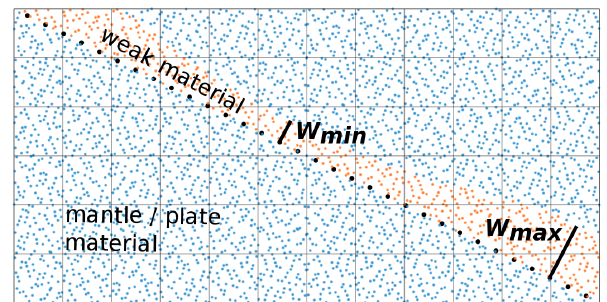
Figure 3. Schematic of the embedded fault (EF) implementation. The EF is a modification to the standard weak layer approach (WL). As with the WL, shear localizes due to a finite-width layer of weak material (represented by orange particles). A reference line of tracer particles (black points) is advected with the flow, at the base of the weak material layer. This line provides a reference to enforce width limits on the weak material, denoted by W min and W max . At each time step we remap material types based on the relative position of the material particles to the reference line. Note that the element size here is not shown to